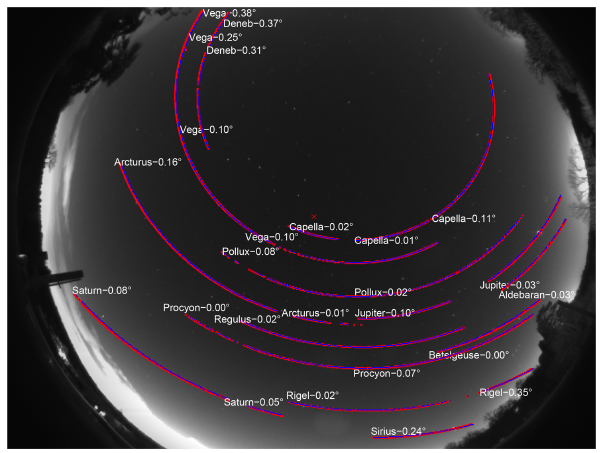
Figure 3. All-sky daytime camera image obtained on the 10 April 2016 at 10:26 showing horizon (red solid circle).